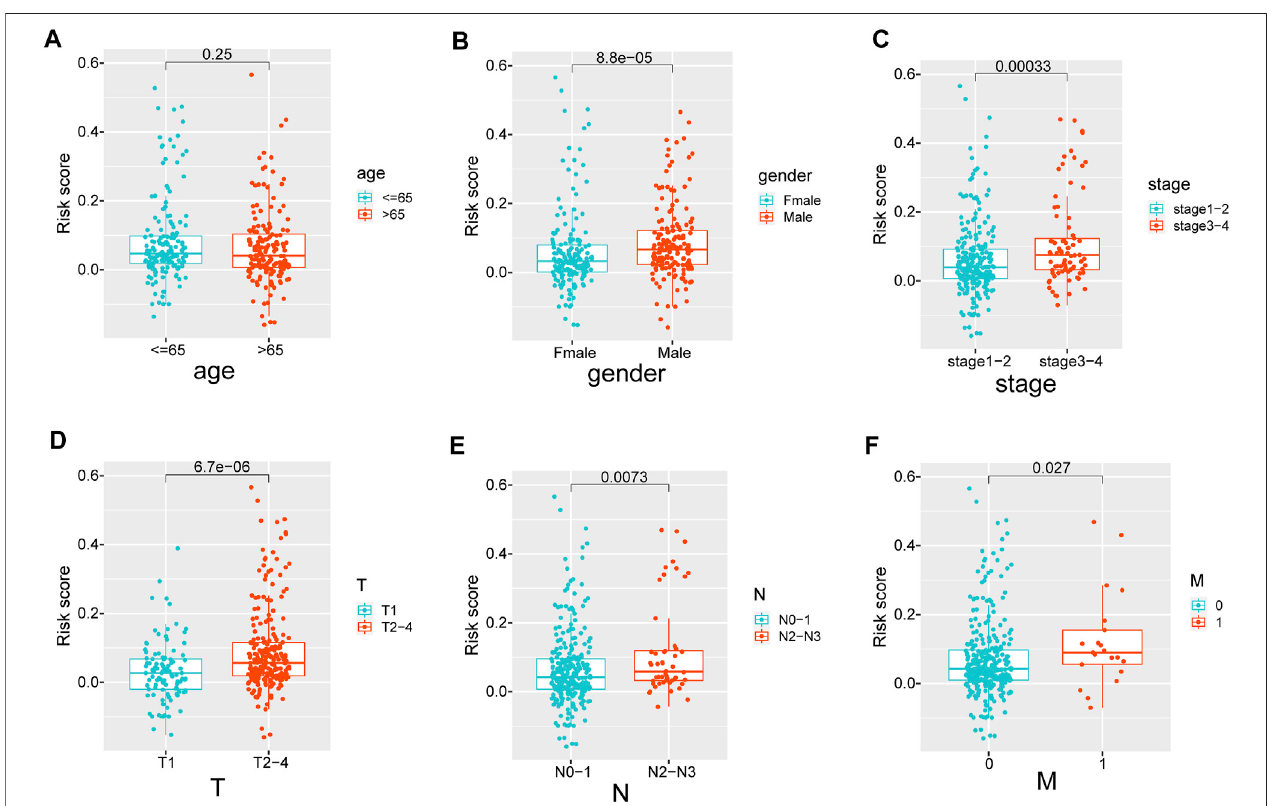
FIGURE 5 | (A – F) The difference in ECMRS between patients strati fi ed by clinicopathological variables. ECMRS = extracellular matrix-related score.